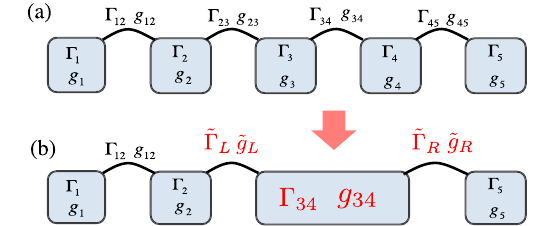
FIG. 1. (a) Coarse-grained model for the many-body localiza- tion transition. Each block represents a finite segment of the one-dimensional system. The coupling parameters g and thermal- ization rates Γ , which characterize single blocks and pairs of adjacent blocks, are explained in the text. (b) The model after the basic RG step of joining the pair of blocks with the fastest interblock thermalization rate Γ ij